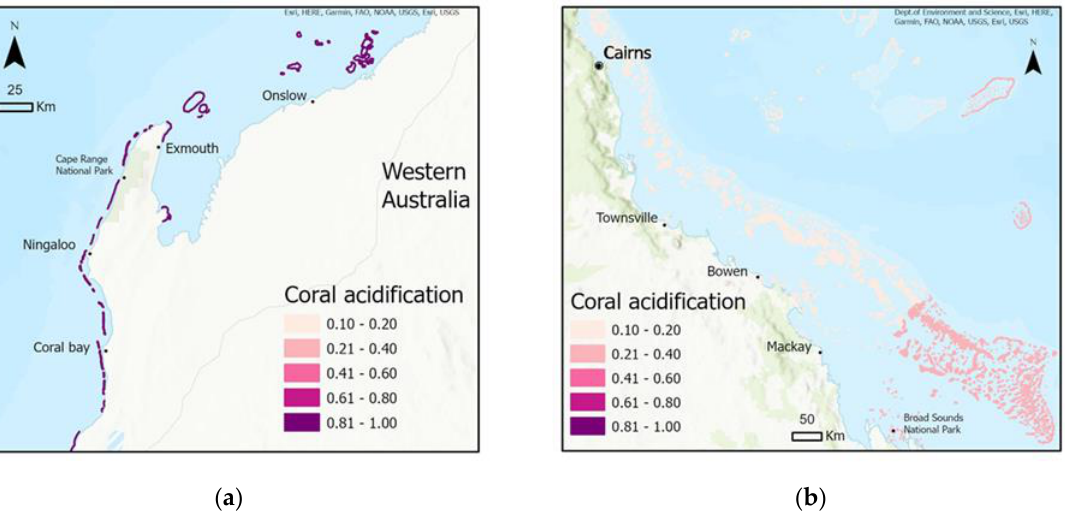
Figure 10. Vulnerability indicator maps of coral acidification in the Ningaloo Reef ( a ) and the southern Great Barrier Reef ( b ). Higher (darker) values denote greater coral acidification.